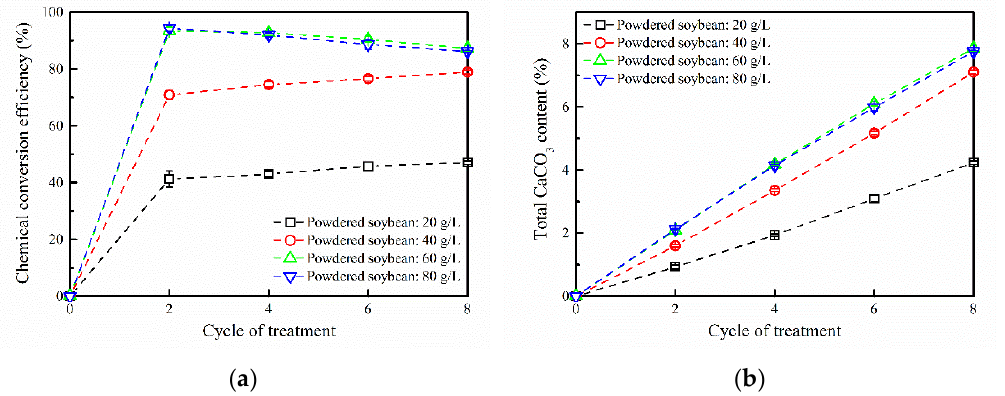
Figure 6. Effect of powdered soybean concentration and treatment cycle on ( a ) chemical conversion efficiency and ( b ) total CaCO 3 content.